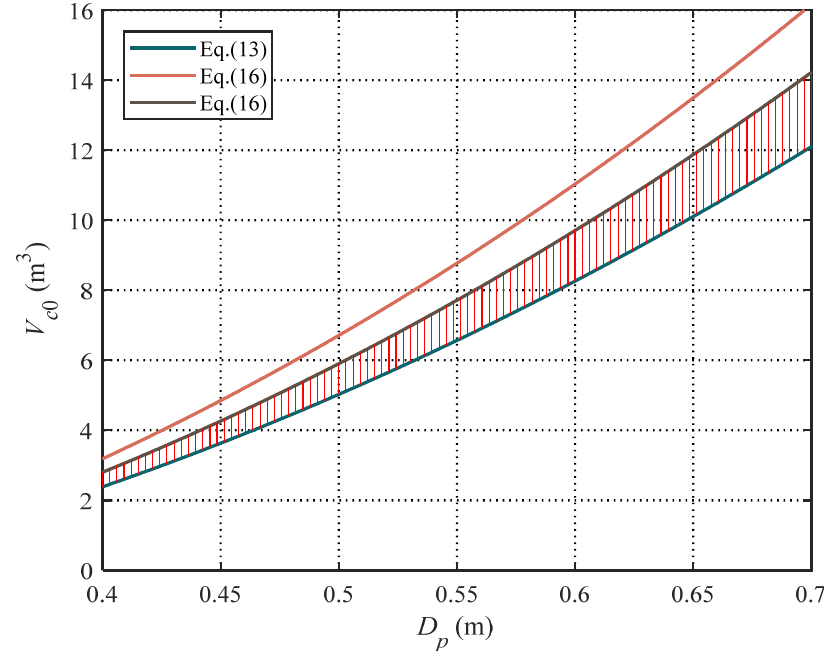
Figure 8. Feasible region for V